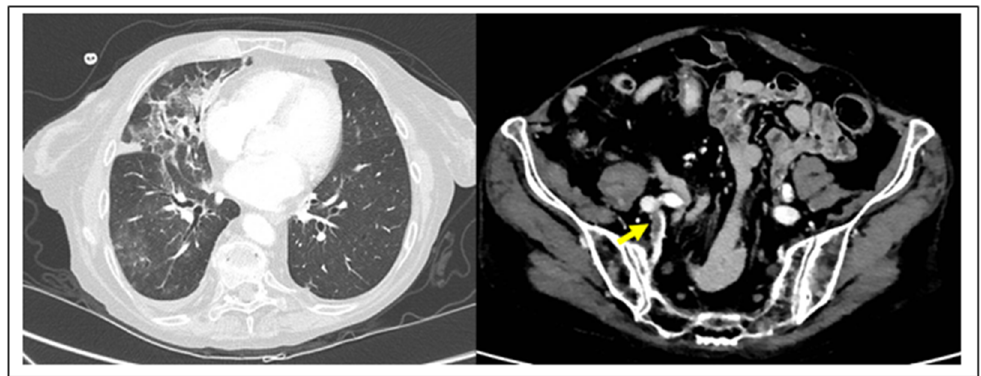
Figure 1. TC imaging of DVT complication in COVID-19 pneumonia. ( Left ) COVID-19 pneumonia with typical association of ground glass opacities and thickening of interlobular septa, particularly visible at the level of the right lung. ( Right ) The same case complicated by right hypogastric DVT (yellow arrow) (D-dimer 5.52 2.0 µg/ml).